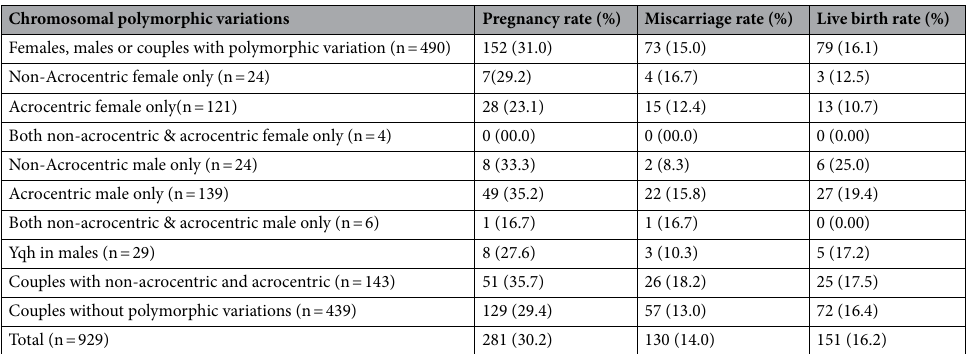
Table 3. Percentages of pregnancy, miscarriage and livebirth rates of the non-acrocentric, acrocentric, Yqh in males and combination of chromosomal polymorphic variations.